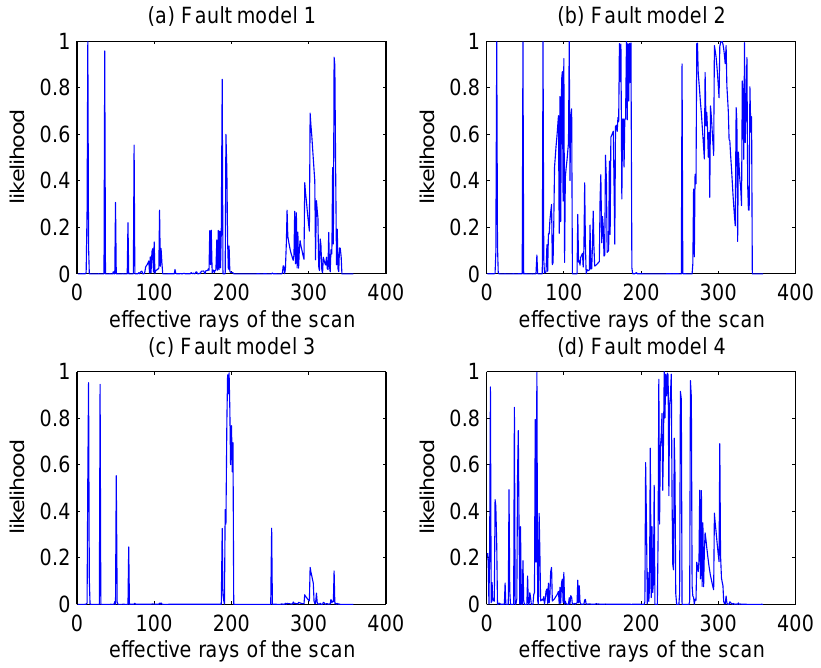
Figure 6. Likelihood of rays of the initial guess of four fault models (time Step